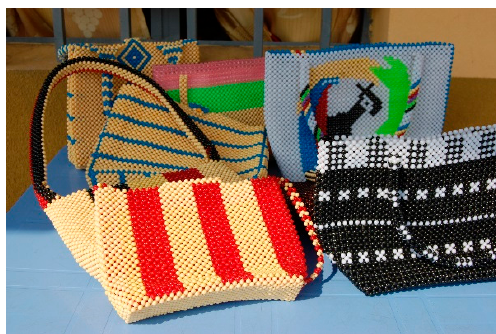
Figure 3. Handbags. Figure 3. Handbags.